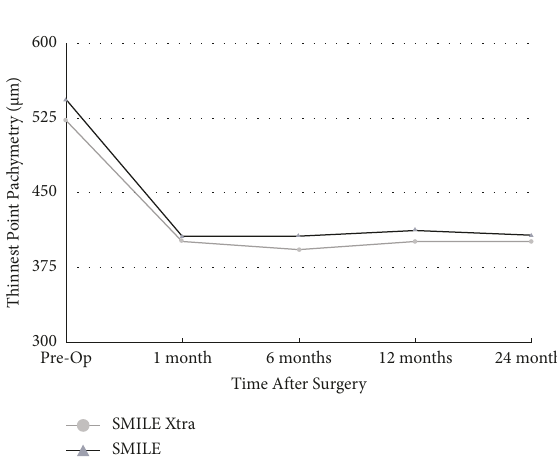
Figure 5: Thinnest point pachymetry following SMILE and SMILE